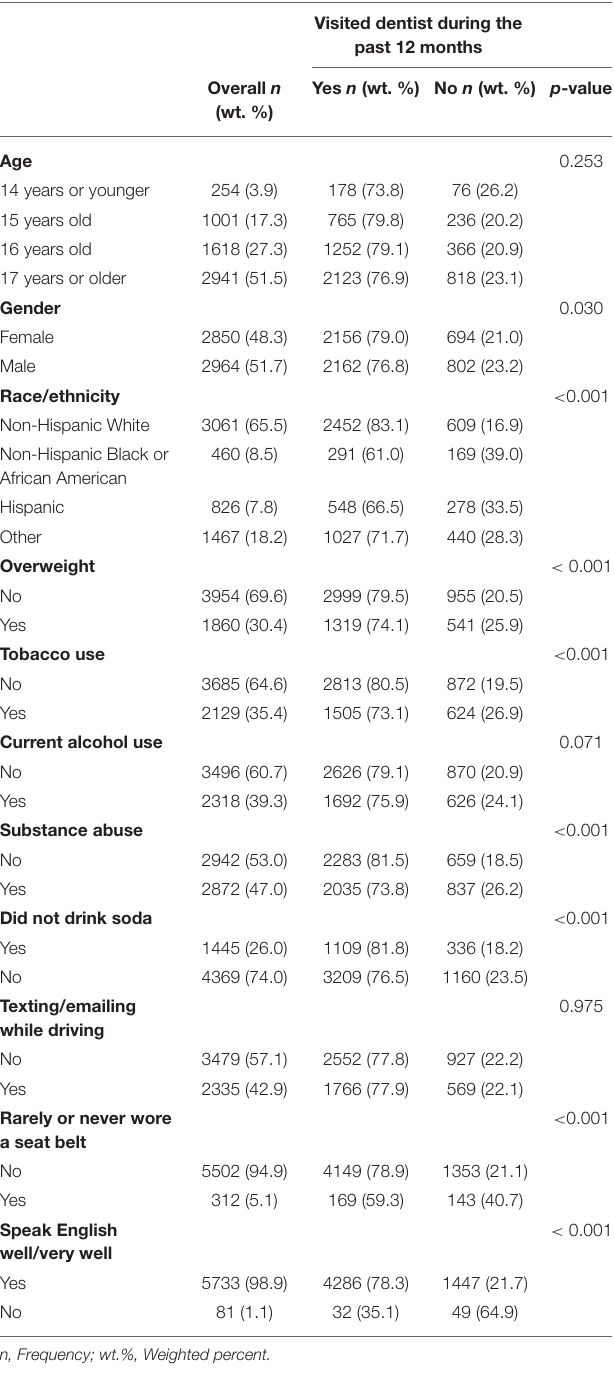
TABLE 1 | Healthcare Utilization Model based characteristics of youth who participated in the 2015 YRBSS survey answering the question regarding having visited a dentist in the past 12 months ( n =